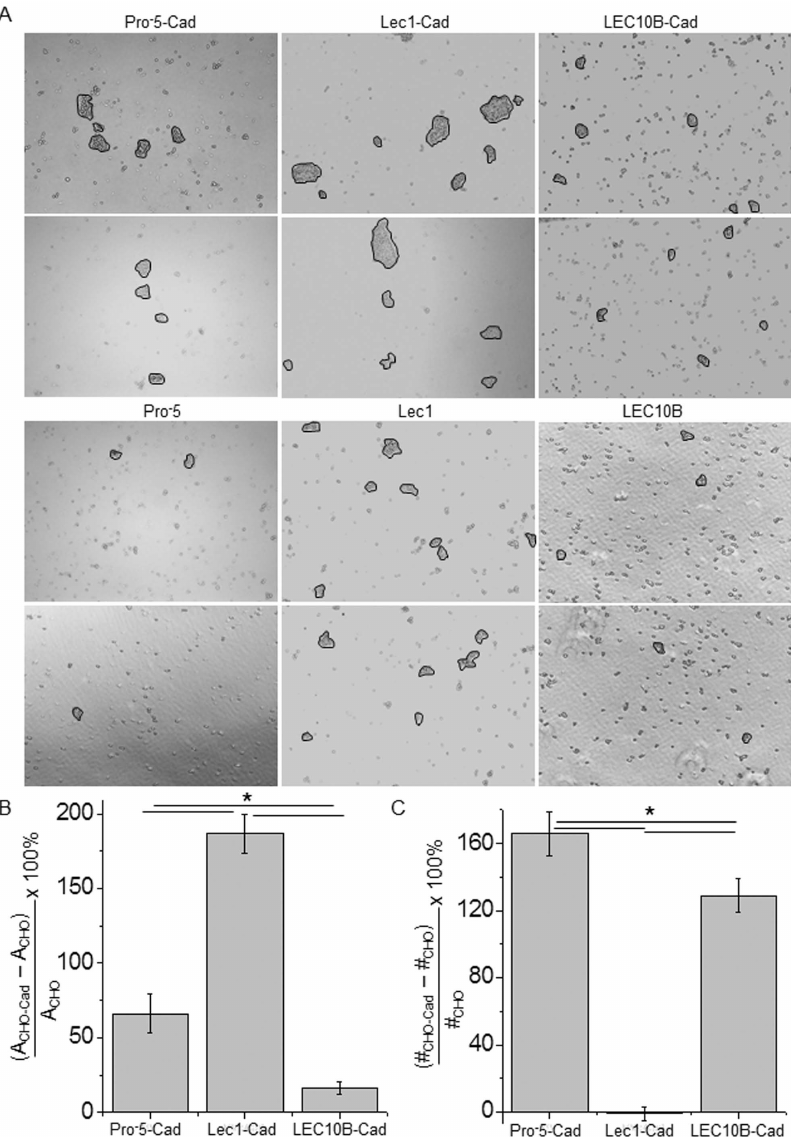
Figure 6. Glycan structures of E-cadherin alter cell dissociation. Microscopy images were acquired for Pro - 5 (left panels), Lec1 (middle panels), and LEC10B (right panels) cells transfected with E-cadherin (upper panels) and nontransfected (bottom panels) (A). Particles of interest are encircled. Percents of particle area (B) and particle number (C) represent increases in the mean values of the particles between the E-cadherin transfected CHO cells and the corresponding nontransfected CHO cells, n =125 images. Asterisks indicate significant differences in mean values at a probability of P , 0.03.